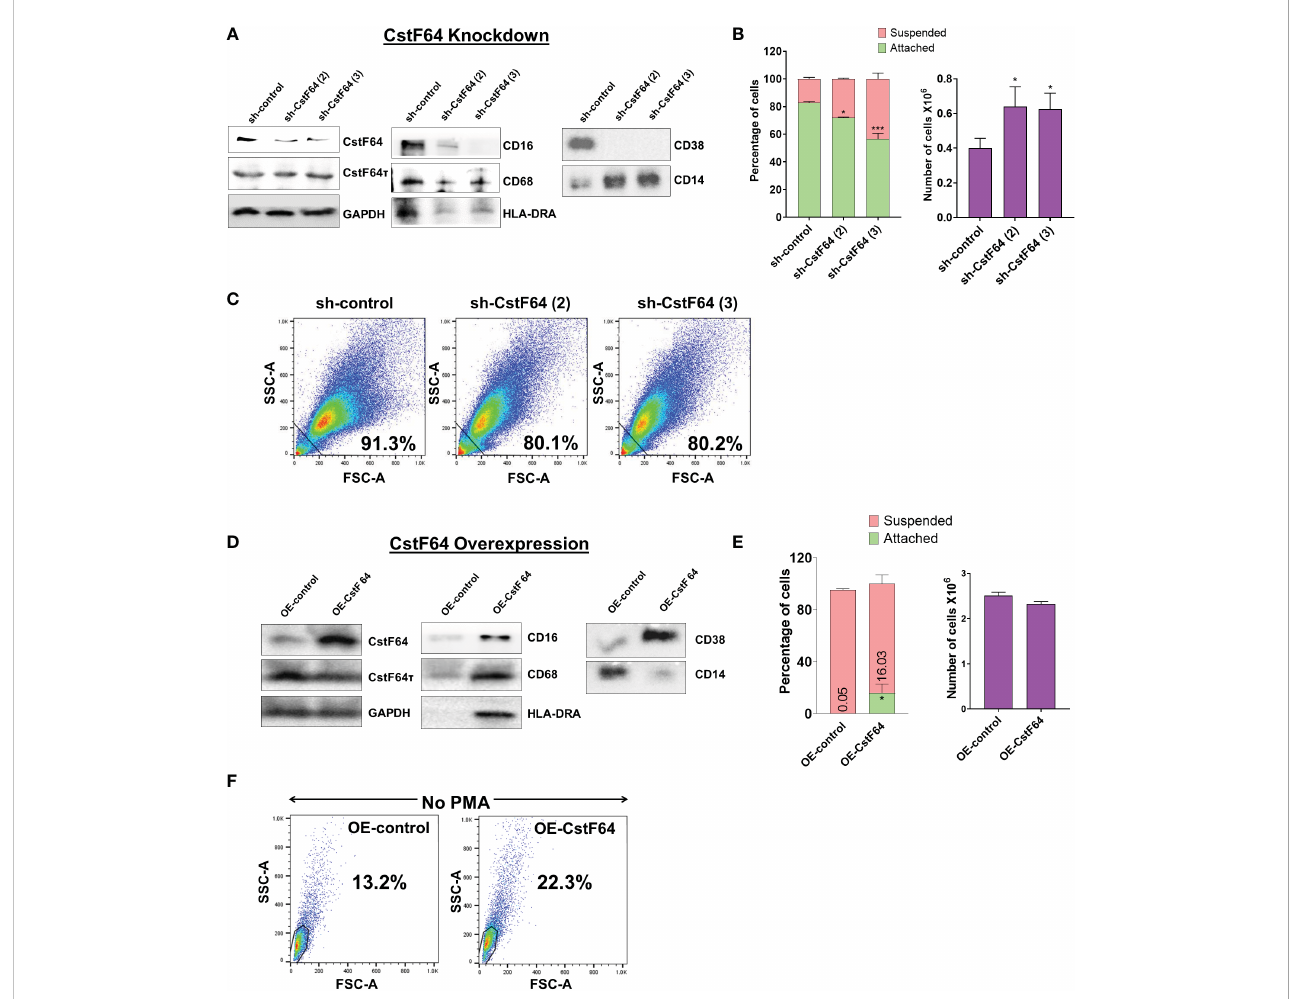
FIGURE 7 Knockdown or overexpression of CstF64 in U937 cells alters macrophage differentiation. (A) Western blot analysis of C/P factors CstF64 and CstF64 t , macrophage-speci fi c markers CD16, CD68, HLA-DRA, CD38 and the monocyte marker CD14 in U937 cells stably transfected with doxycycline-inducible control shRNA and two different CstF64 shRNAs (shRNA 2 and shRNA 3). Addition of 3 nM doxycycline for 3 days supplemented with 30 nM PMA one day prior to harvesting was done for all three cell lines. (B) Attachment assay (left panel) and changes in total number of PMA-treated cells (right panel) after knockdown of CstF64 compared to the shRNA control. Cells were treated with doxycycline, after which equal number of cells were treated with PMA for 24 h and then counted. The fi gures are representative of at least three independent experiments. (C) Changes in cellular complexity determined by FACs analysis of side (SSC) and forward scattering (FSC) values for 24h PMA-treated U937 cells stably expressing control shRNA and shRNA against CstF64. (D) Western blot analysis of C/P factors CstF64, CstF64 t and macrophage-speci fi c markers CD68, HLA-DR, CD38 and the monocyte marker CD14 in U937 cells stably transfected with control overexpression vector (OE-control) and those overexpressing CstF64 (OE-CstF64) and treated with 3 nM doxycycline for 3 days prior to harvesting. No PMA treatment has been done. (E) Attachment assay (left panel) and changes in total number of cells (right panel) after overexpression of CstF64 compared to the OE-control. (F) Changes in cellular complexity or granularity determined by FACs analysis of side (SSC) and forward scattering (FSC) values for doxycycline-induced U937 cells transfected with OE-control or OE-CstF64. Percentage indicates a quantitation of cells that have altered granularity. For Fig. 7B and E, P value <0.05 was considered signi fi cant, where * = P ≤ 0.05; *** = P ≤